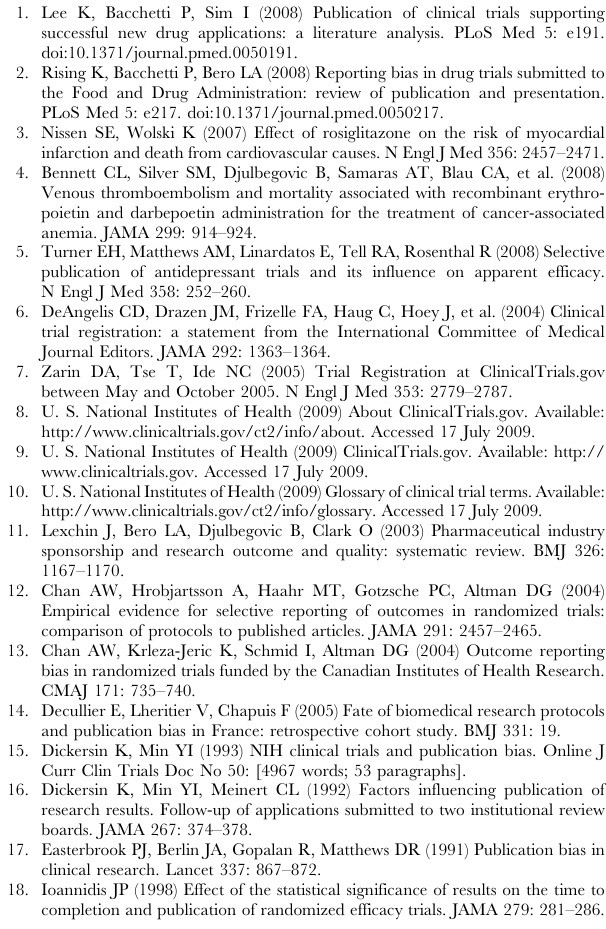
Table S1 ClinicalTrials.gov mandatory and optional data elements for intervention